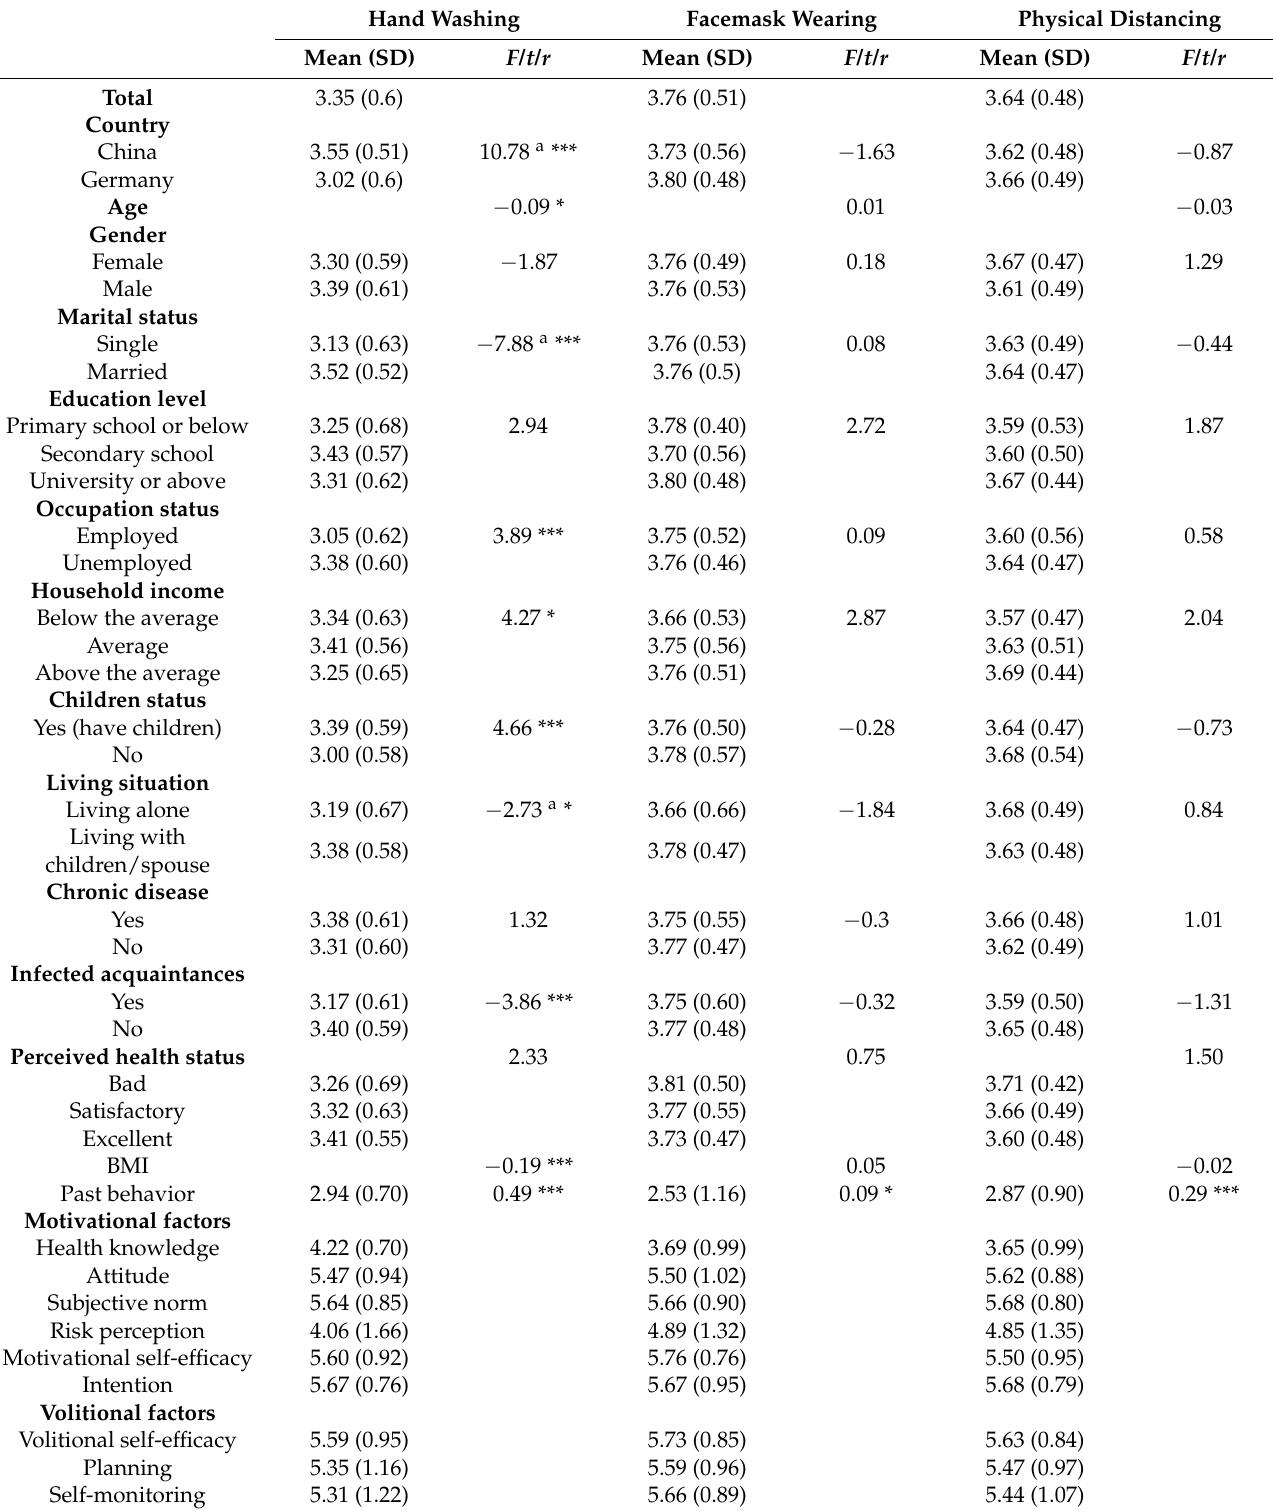
Table 2. Descriptive statistics for the associations of demographic information, past behaviors with three preventive behaviors, as well as motivational factors and volitional factors in the total sample ( n =